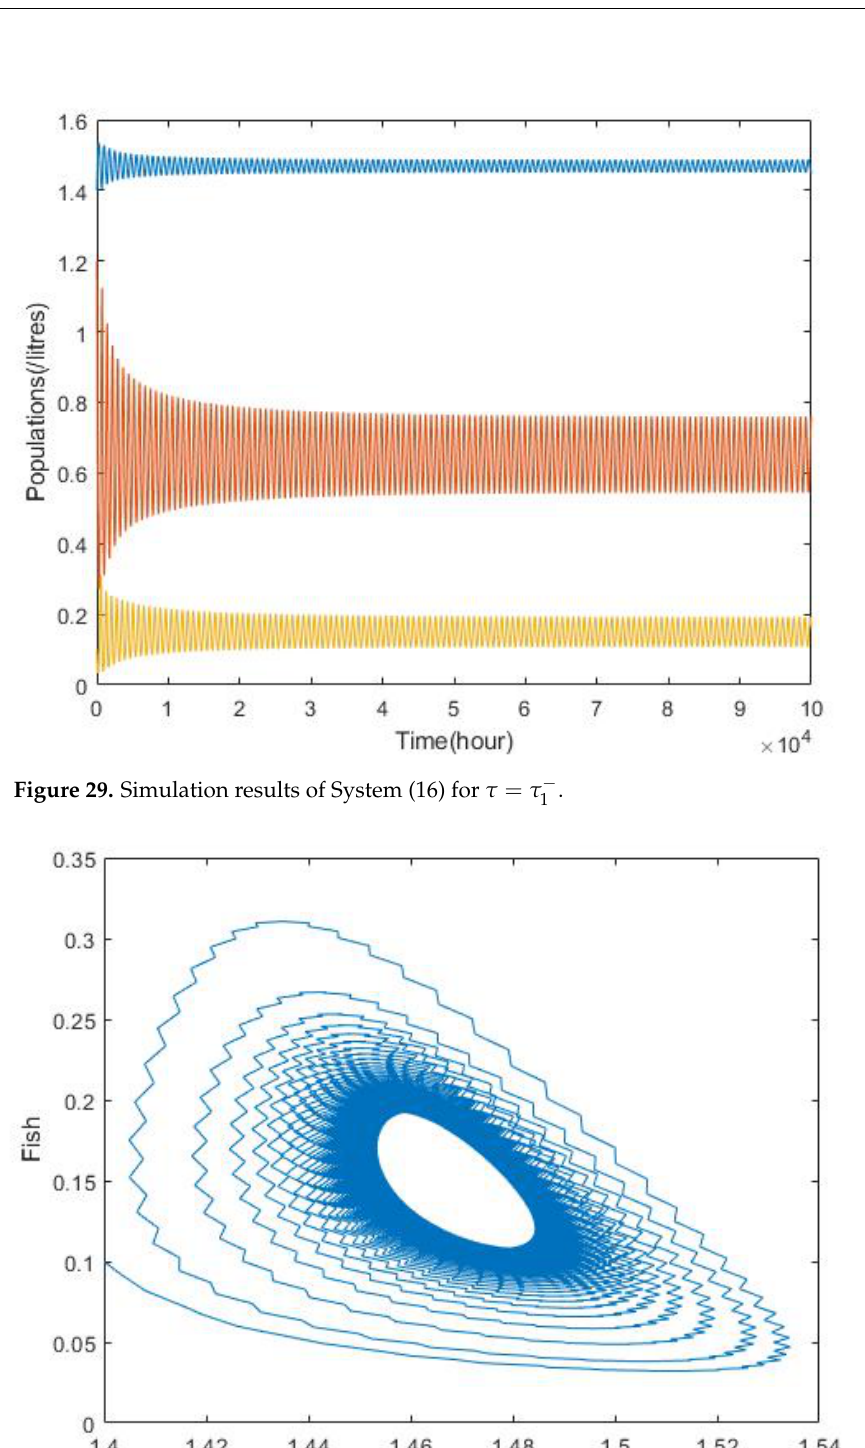
Figure 30. Equilibrium between the TPP and fish populations loses its stability for τ = τ −